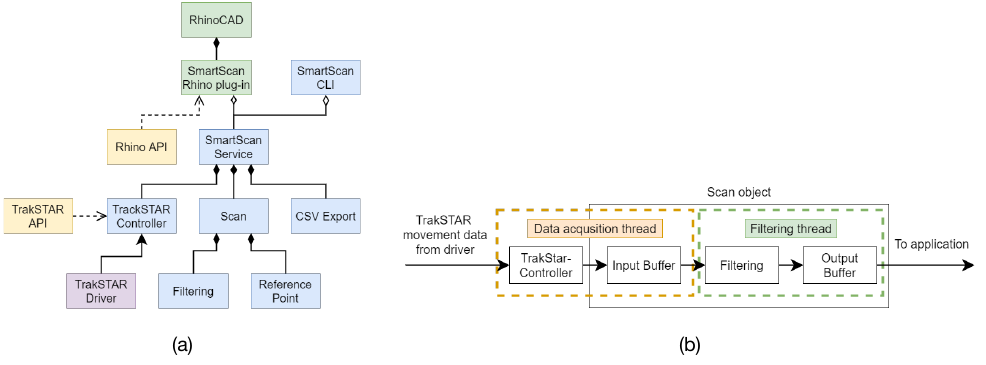
Figure 2. Software architecture ( a ). Green: RhinoCAD, SmartScan Rhino plug-in; blue: SmartScanSer- vice, TrakSTAR controller, scan, CSVExport, filtering, ReferencePoint; yellow: RhinoAPI, TrakSTAR API; purple: TrakSTAR driver. Data processing pipeline ( b ). Yellow: acquisition thread; green: filtering